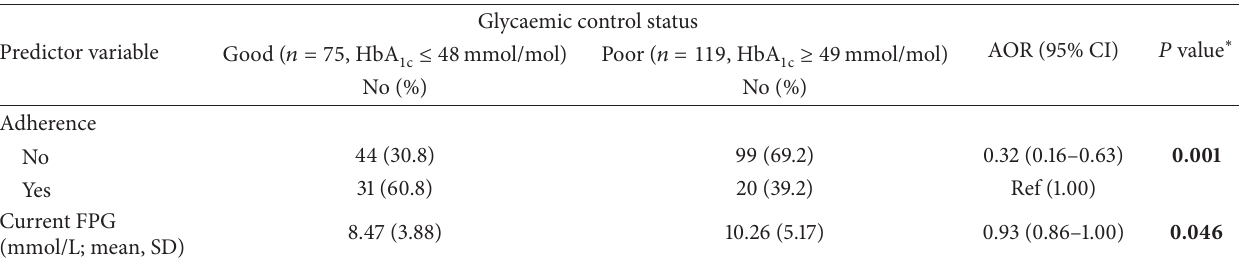
Table 3: Multivariate binary logistic regression model-determining predictors of glycaemic control status. Predictor